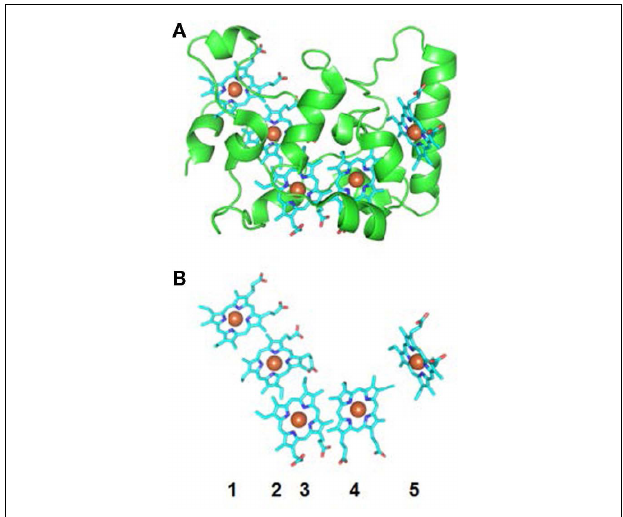
FIGURE 1 | Molecular structure of NrfB of E. coli . (A) Crystal structure of NrfB (PDB-ID: 2OZY) showing the peptide chain (green) and hemes (Blue). (B) Arrangement of NrfB hemes shown in the same orientation as panel (A) .The hemes are numbered according to the position of their corresponding CXXCH binding motif in the NrfB amino acid